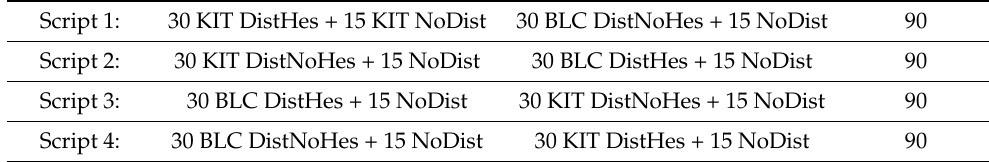
Table 2. Four different scripts to mitigate order effects. Each participant was assigned one script